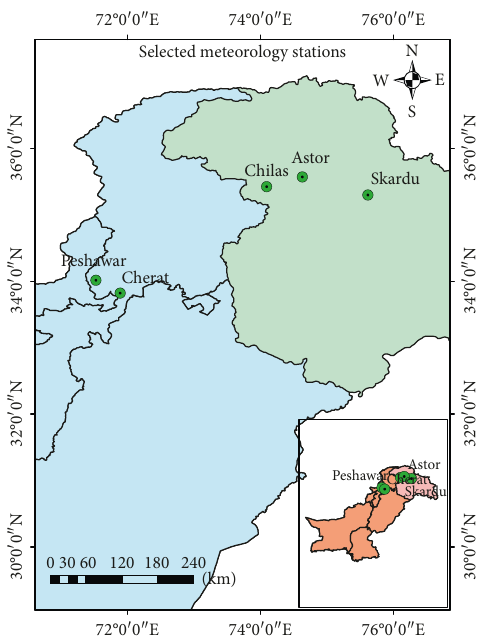
Figure 1: Map of selected locations of study